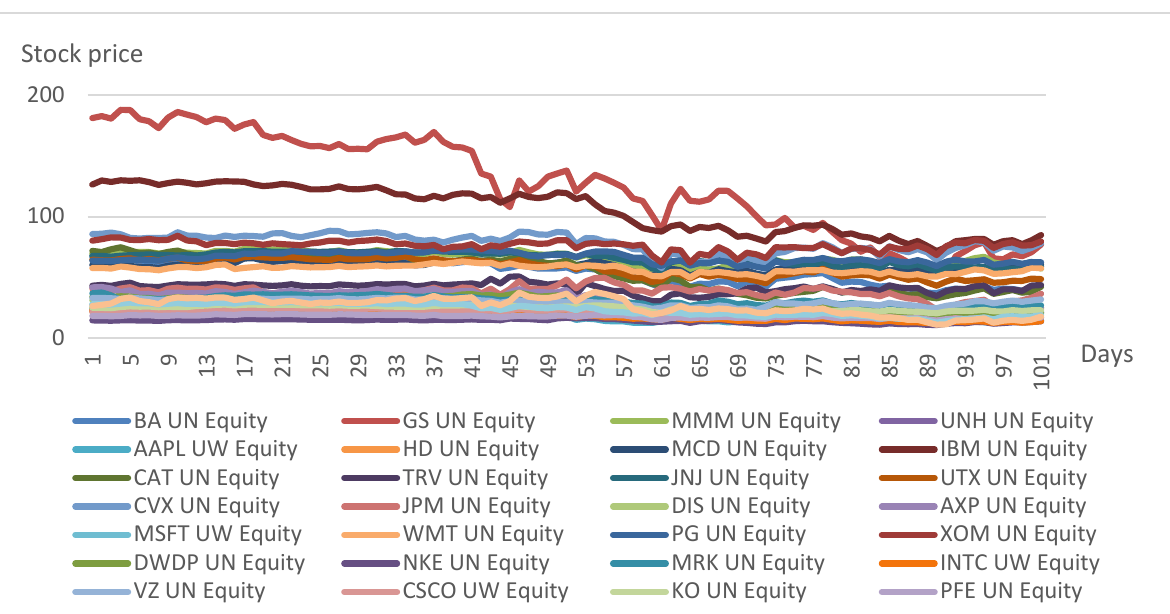
Figure 3. US stock price growth during the 2007–2008 financial crisis (source: compiled by the authors based on Yahoo Finance data).